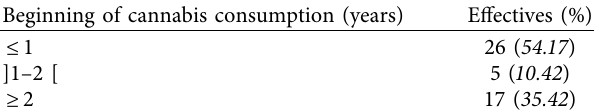
Table 1: Sociodemographic characteristics of subjects.